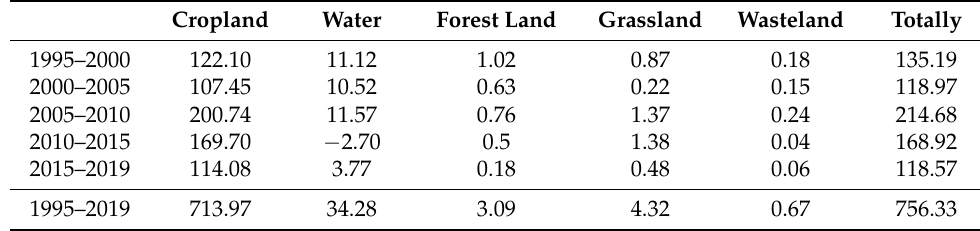
Table 3. Sources of new UCL in Wuhan, 1995–2019.